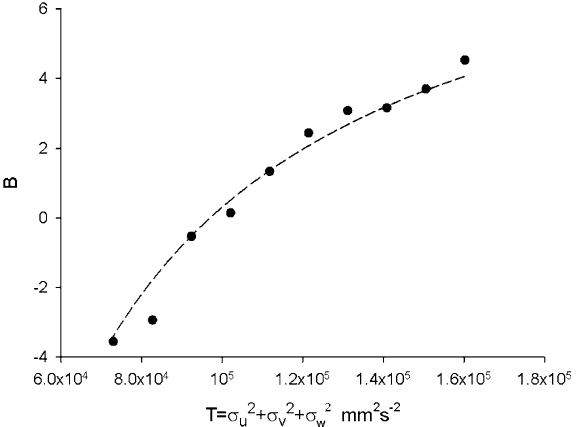
Figure 10. Second virial coefficient for the largest laboratory swarm (•) mirrors theoretical expectations for a swarm with slabs and corresponds to a van der Waals gas (dashed line). Data are taken from Sinhuber et al. 14 ; swarm Ob1 which contains on average 94